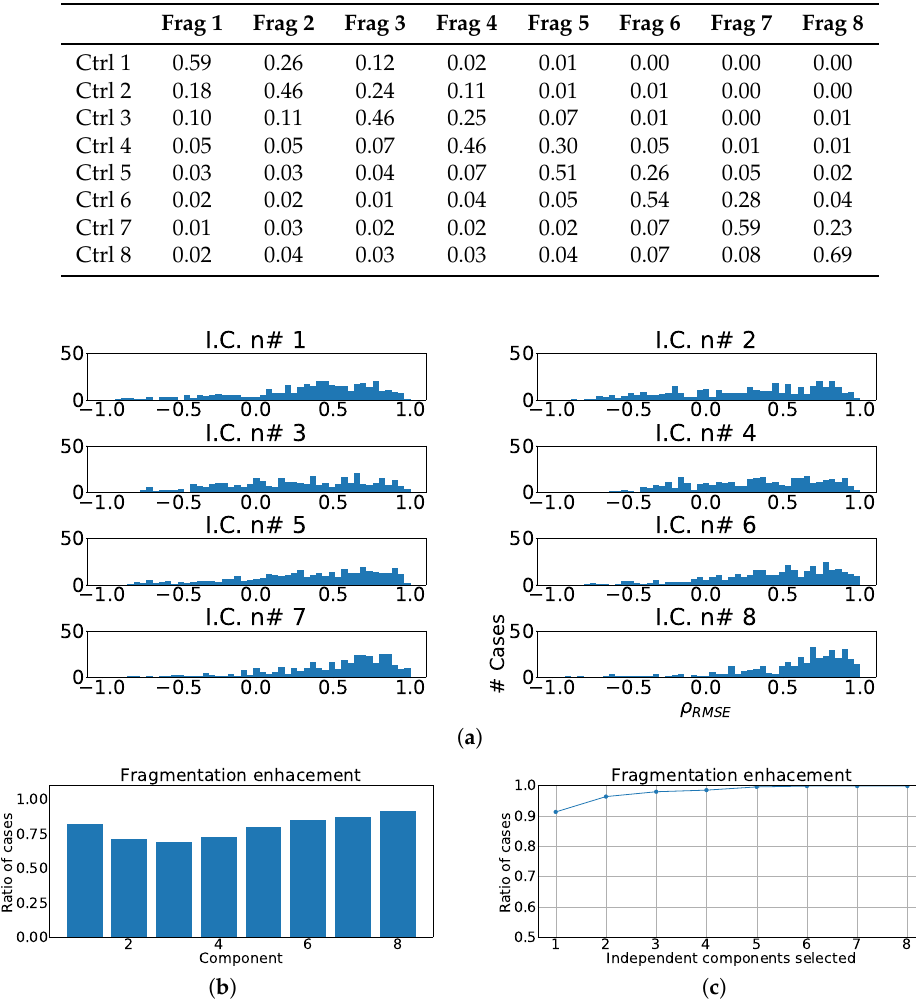
Table 7. Normalized confusion matrix of ICA over 8 independent lead model. The ij value of the table represent the ratio of i -th component of control patient that is paired with the j -th component of synthetically fragmented patient according to the value of PCC.